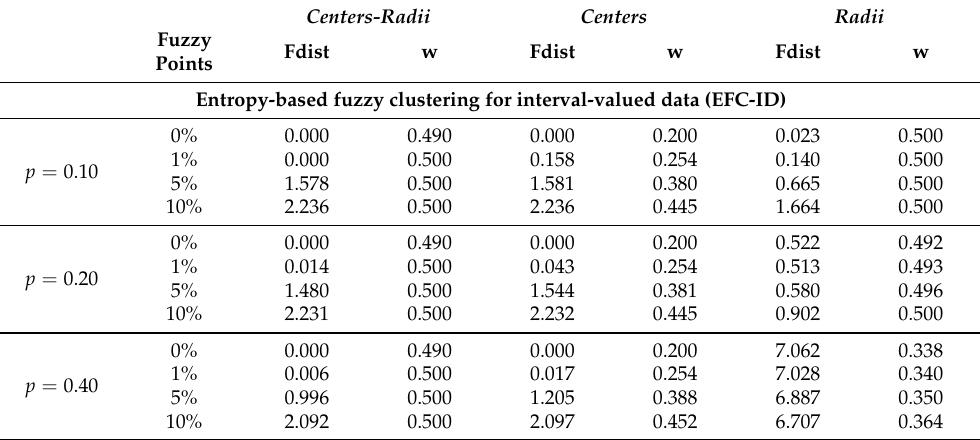
Table 4. Clustering models performance with well-separated clusters (0% of fuzzy points) and not well-separated clusters (1%, 5%, 10% of fuzzy points).